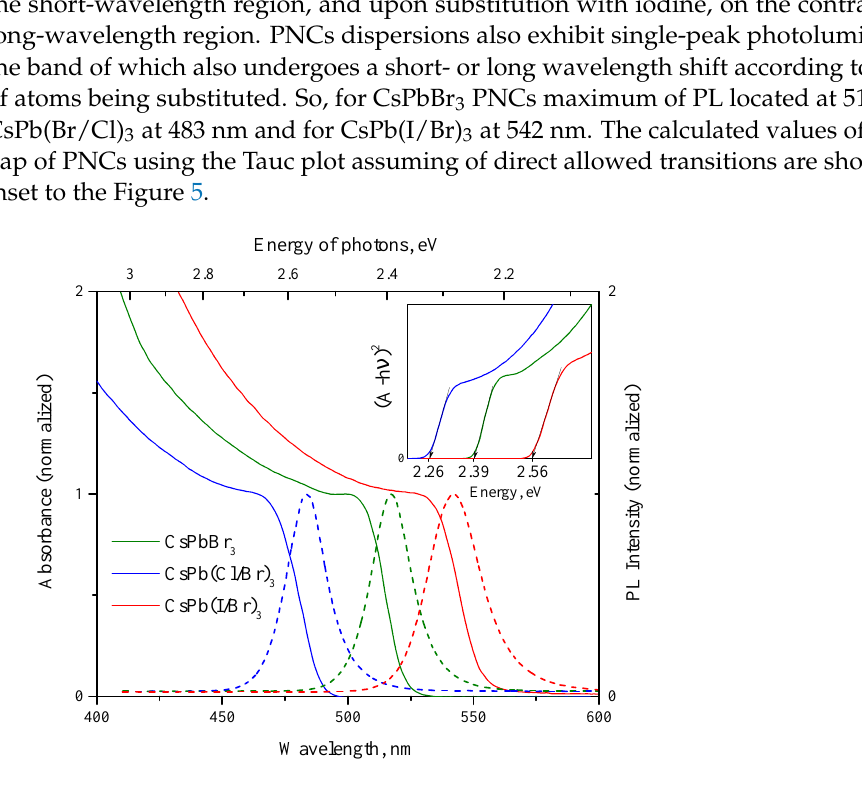
Figure 5. Absorbance (solid lines) and PL (dashed lines) spectra of PNCs hexane dispersions. On the inset shown determination of optical band gaps of PNCs using Tauc